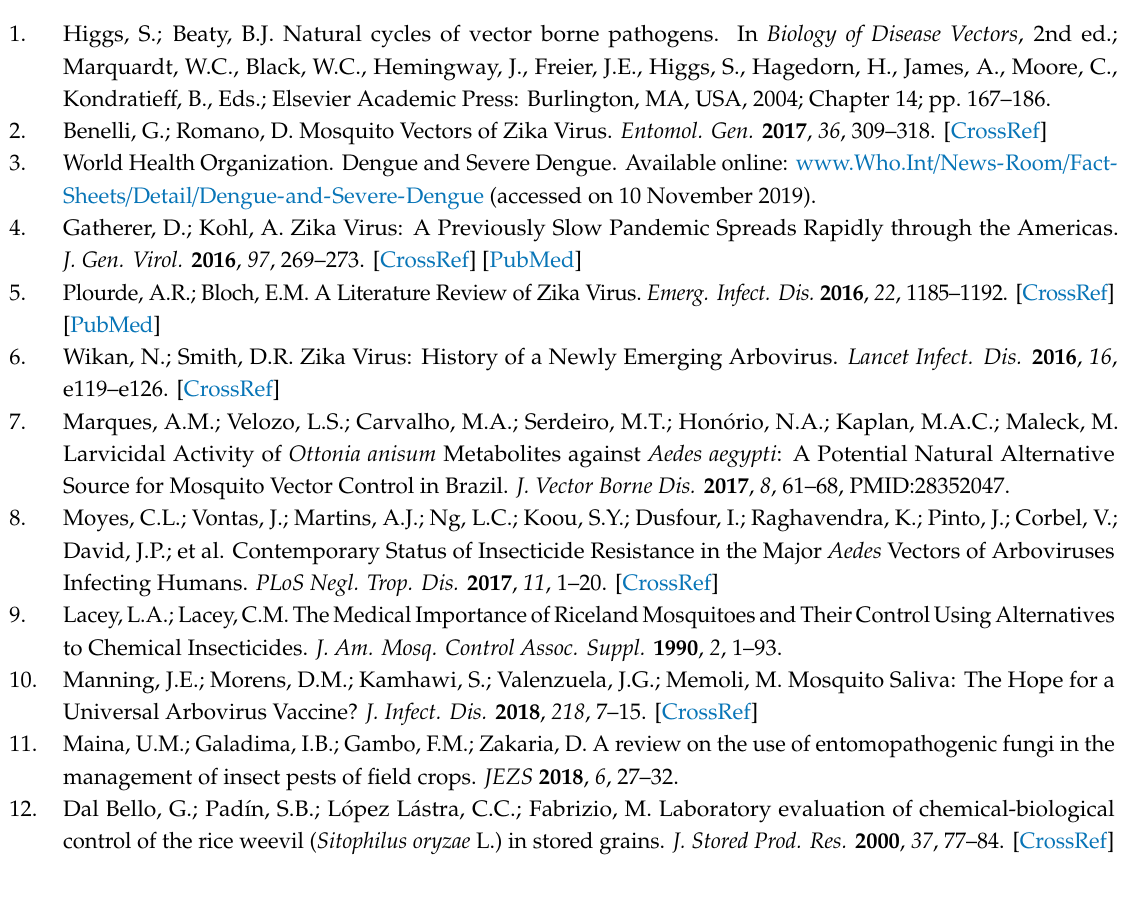
Table S1: Kaplan-Meier analysis of all survival curves (all treatments), pair-wise comparisons of M. anisopliae -treated blood-fed and sucrose-fed female A. aegypti and comparisons of fungus-treated insects to their respective controls. Table S2: Summary of results from analysis of the immune related genes with di ff erent feeding regimes following fungal infection. Figure S1: E ff ects of Metarhizium anisopliae conidia on the survival rates of adults female Aedes aegypti mosquitoes exposed to di ff erent concentrations of the